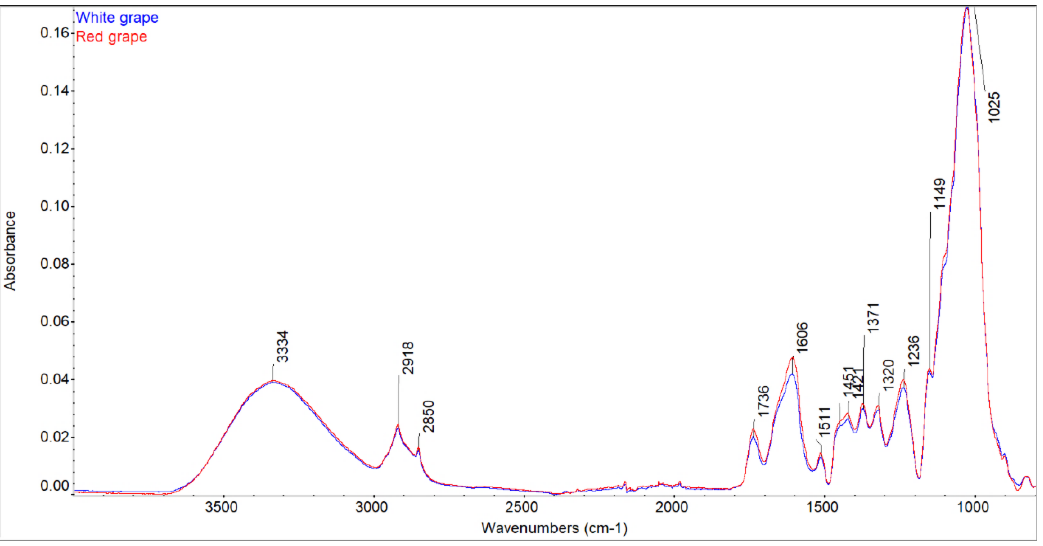
Figure 2. FTIR spectra of white and red grape samples.